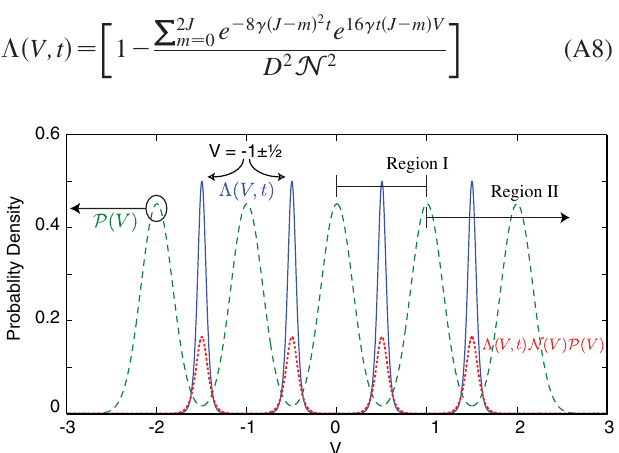
FIG. 17. The dashed green curve is the probability distribution P ð V Þ , Eq. (A6); the solid blue line is (cid:2) ð V; t Þ , Eq. (A9), shown for D ¼ 5 at t ¼ 4 (cid:2) (cid:2) 1 . The dotted red curve is (cid:2) ð V; t Þ N ð V Þ P ð V Þ (multiplied by 20 so that it can be viewed on the same scale). Also plotted are regions for the two- eigenvalue expression for the impurity